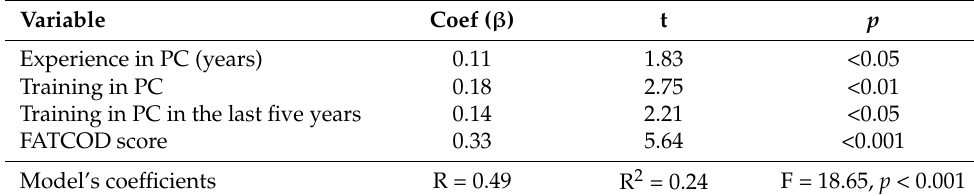
Table 7. Regression model for the outcome “level of knowledge in palliative care”.